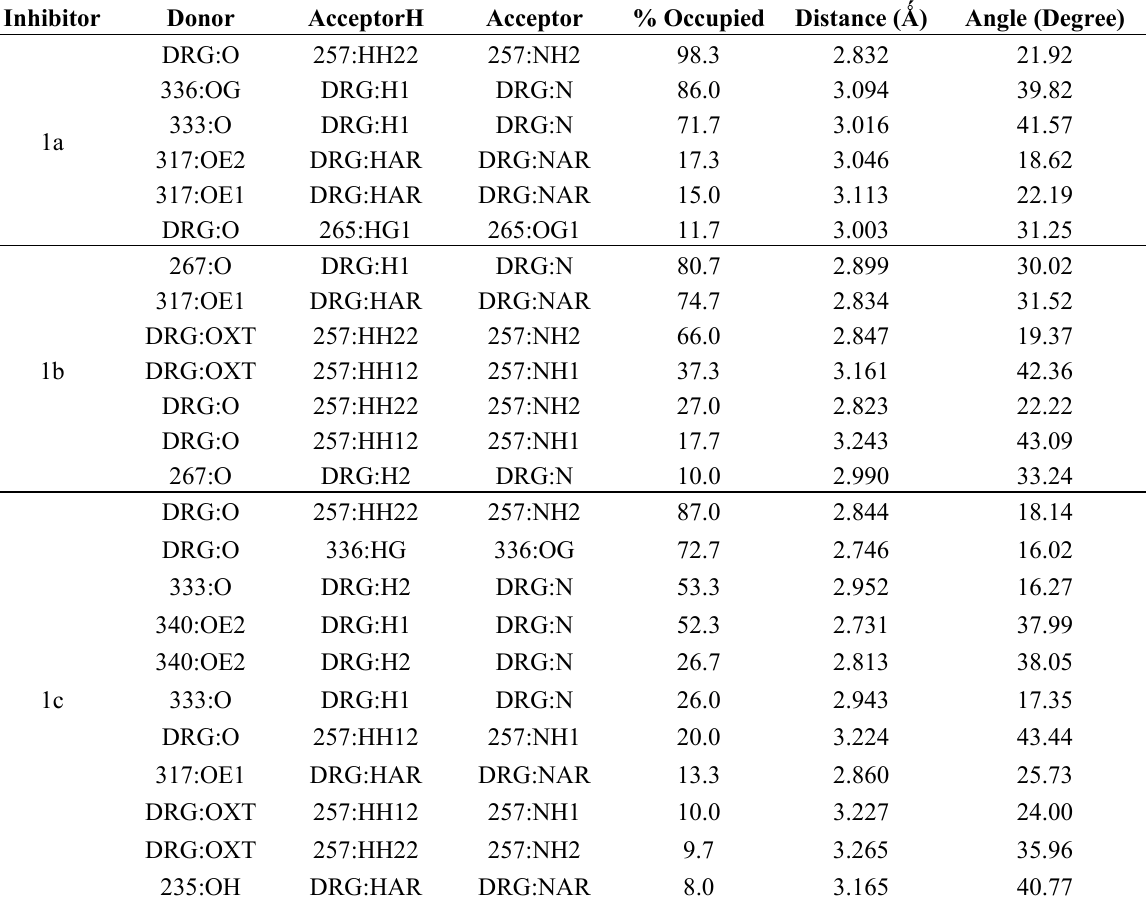
Table 2. Hydrogen bond analysis of the inhibitors into TPH1 binding site based on MD